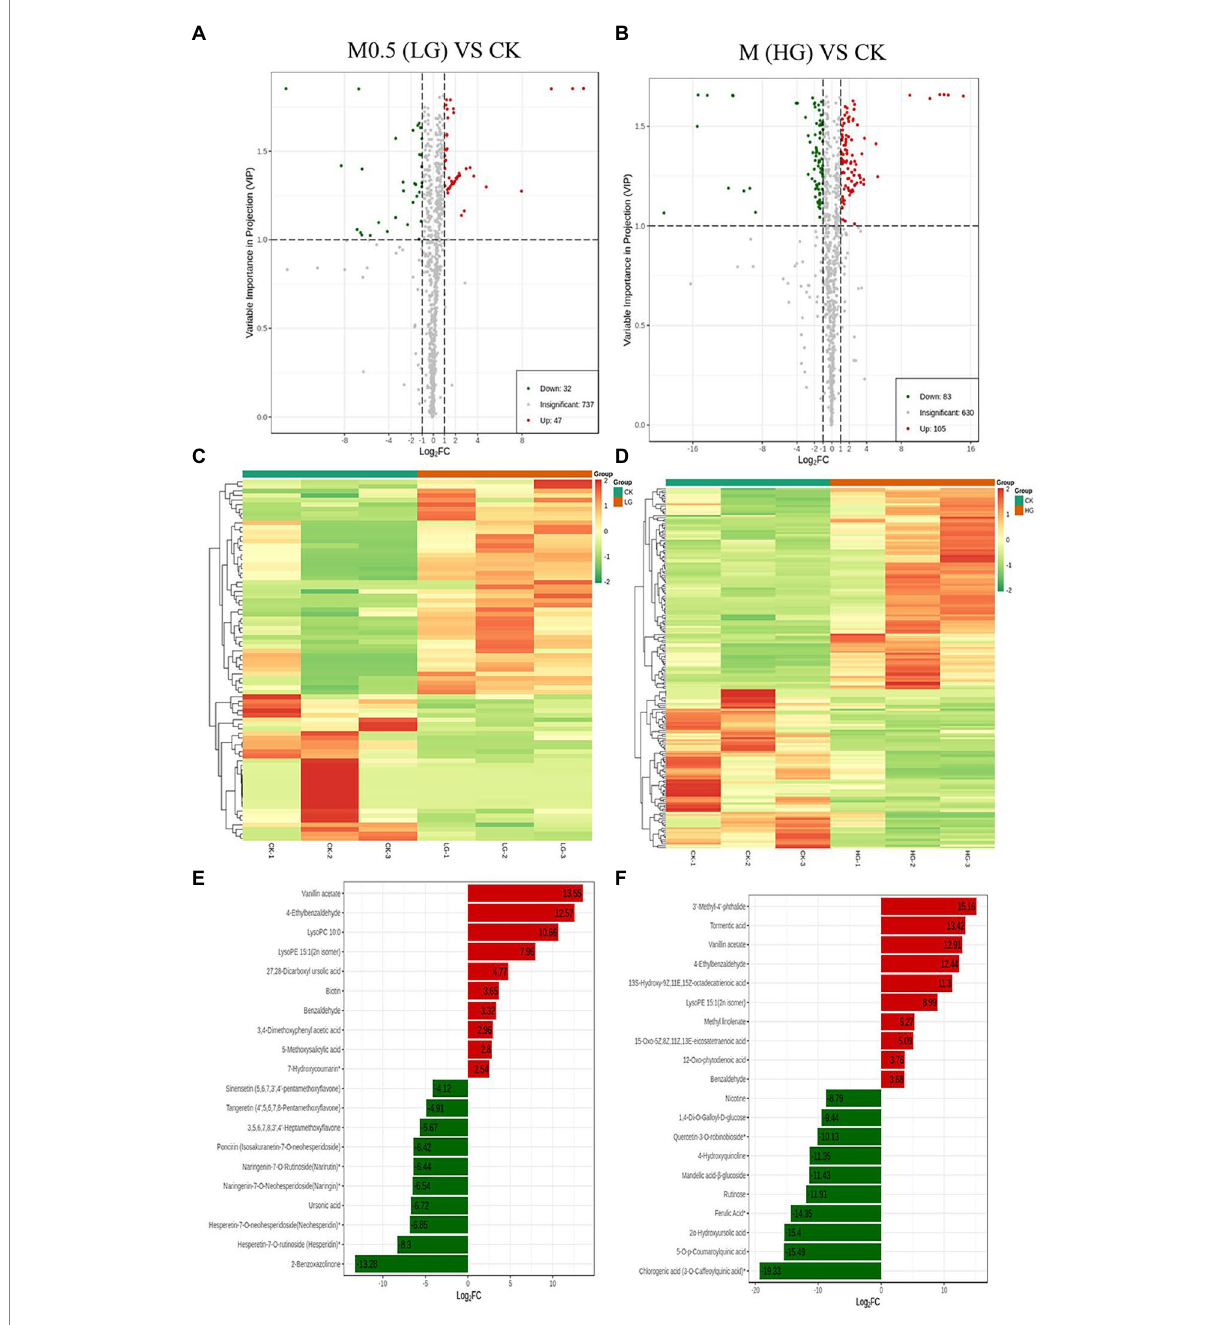
FIGURE 3 Up- and downregulation of differentially accumulated metabolites (DAMs) in two comparison groups. Volcano plot (A) and heatmap (C) of DAMs in M0.5 (LG) vs. CK. Volcano plot (B) and heatmap (D) of DAMs in M (HG) vs. CK. The top ten DAMs in M0.5 (LG) vs. CK (E) and in M (HG) vs. CK (F) , respectively. Each dot in the volcano plot denotes one metabolite. The green spots denote metabolites with down-regulated differential expression; the red spots denote metabolites with up-regulated differential expression; the gray spots denote the detected metabolites without significant differences. All treatments were consistent with the